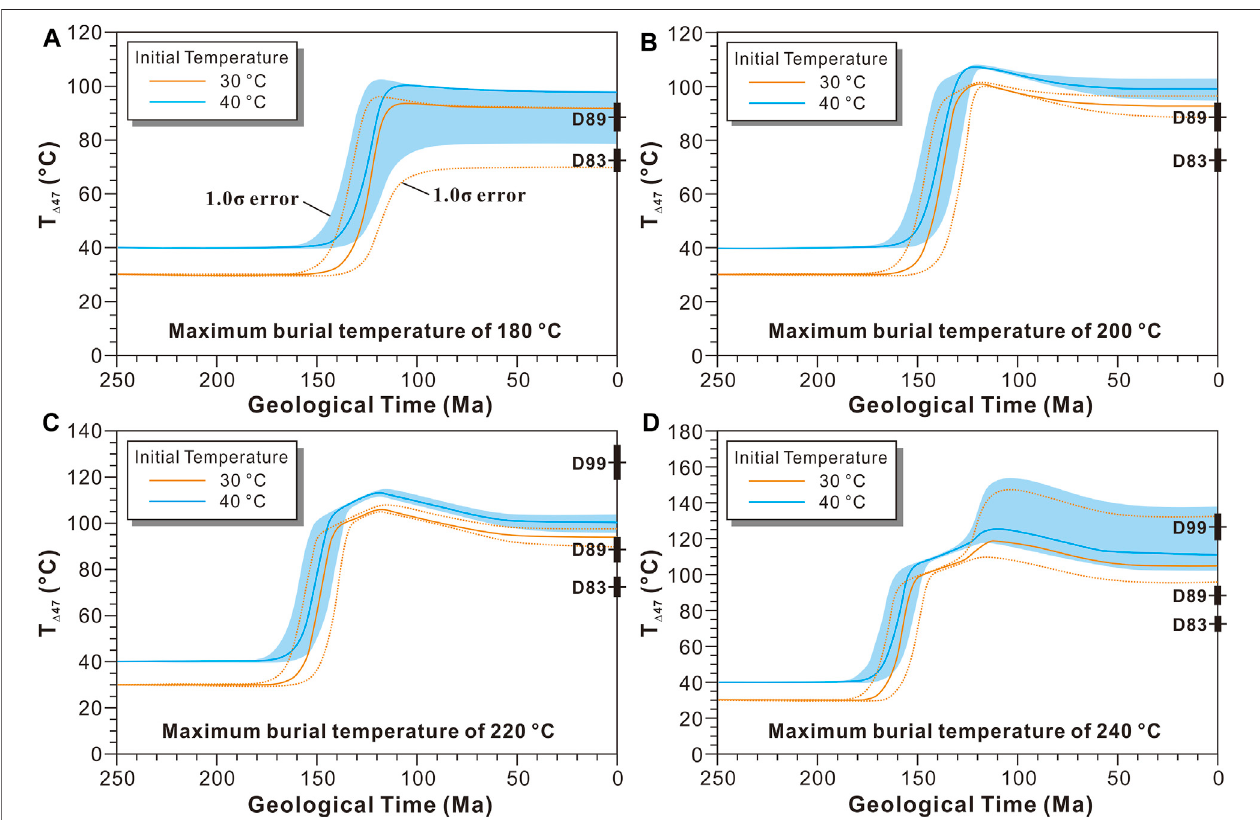
FIGURE 7 | The general clumped isotope temperature (T Δ 47 ) evolution of the dolostone from the Puguang gas fi eld, assuming that the dolomite crystalized at 30 and 40 ° C at 250 Ma, and the maximum burial temperature reached 180, 200, 220, or 240 ° C and then decreased to 110 ° C during the late uplift event. The solid-state reordering model for dolomite is from Lloyd et al. (2018). Note: the D83, D89, and D99 represent dolostone samples, the black horizontal lines and columns in the right side represent the T Δ 47 and error bar of the samples D83, D89, and D99.